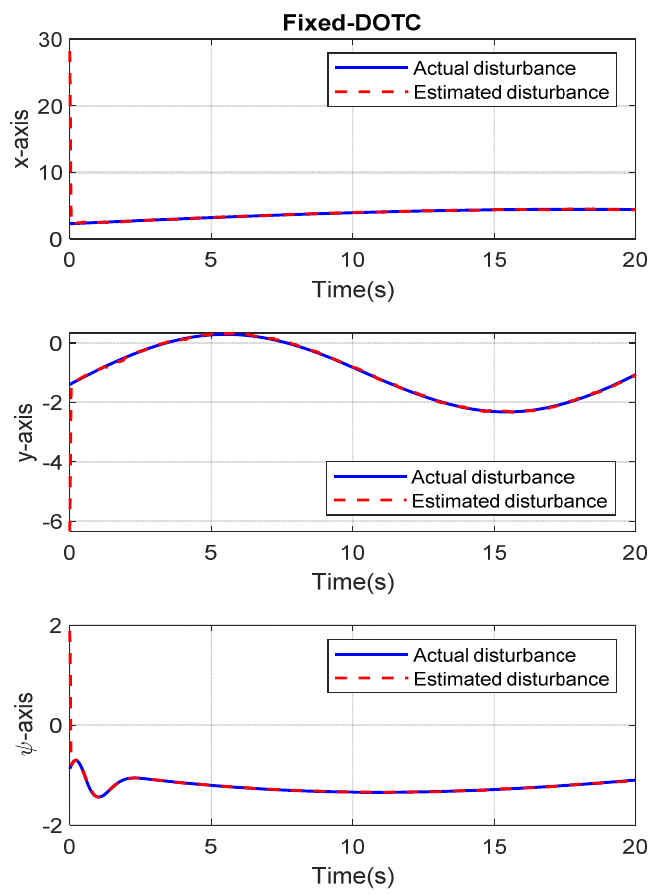
Figure 4. The actual total uncertainty and its estimation under the Fixed-DOTC in part 1.